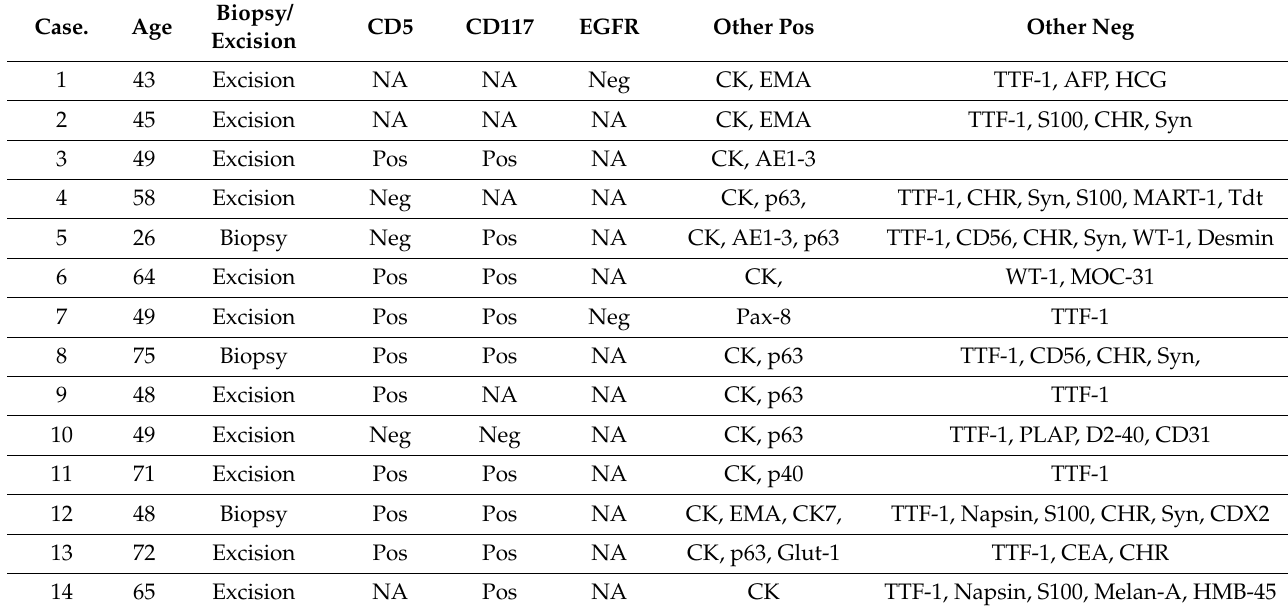
Table 3. Surgical treatment and Immunohistochemistry panel used in the case of thymic carcinoma with second malignan- cies.